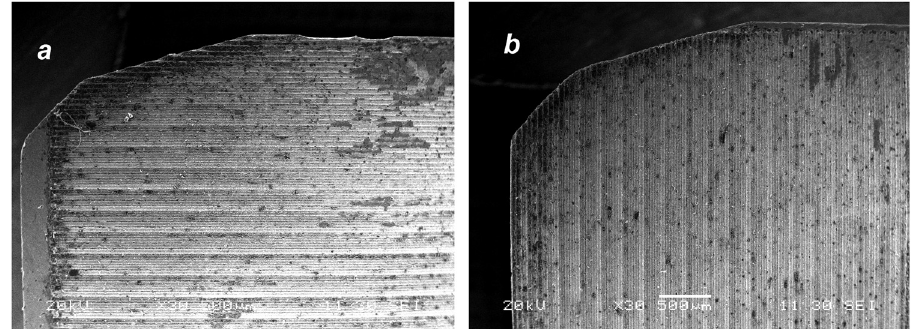
Figure 7: Micromorphology of stripe micro - textured tool after cutting: ( a ) parallel, ( b )